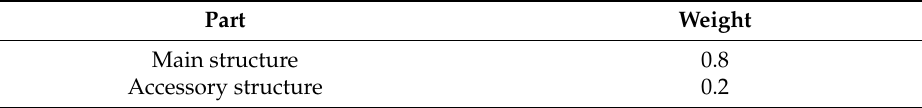
Table 10. Weights of main structure and accessory structure.